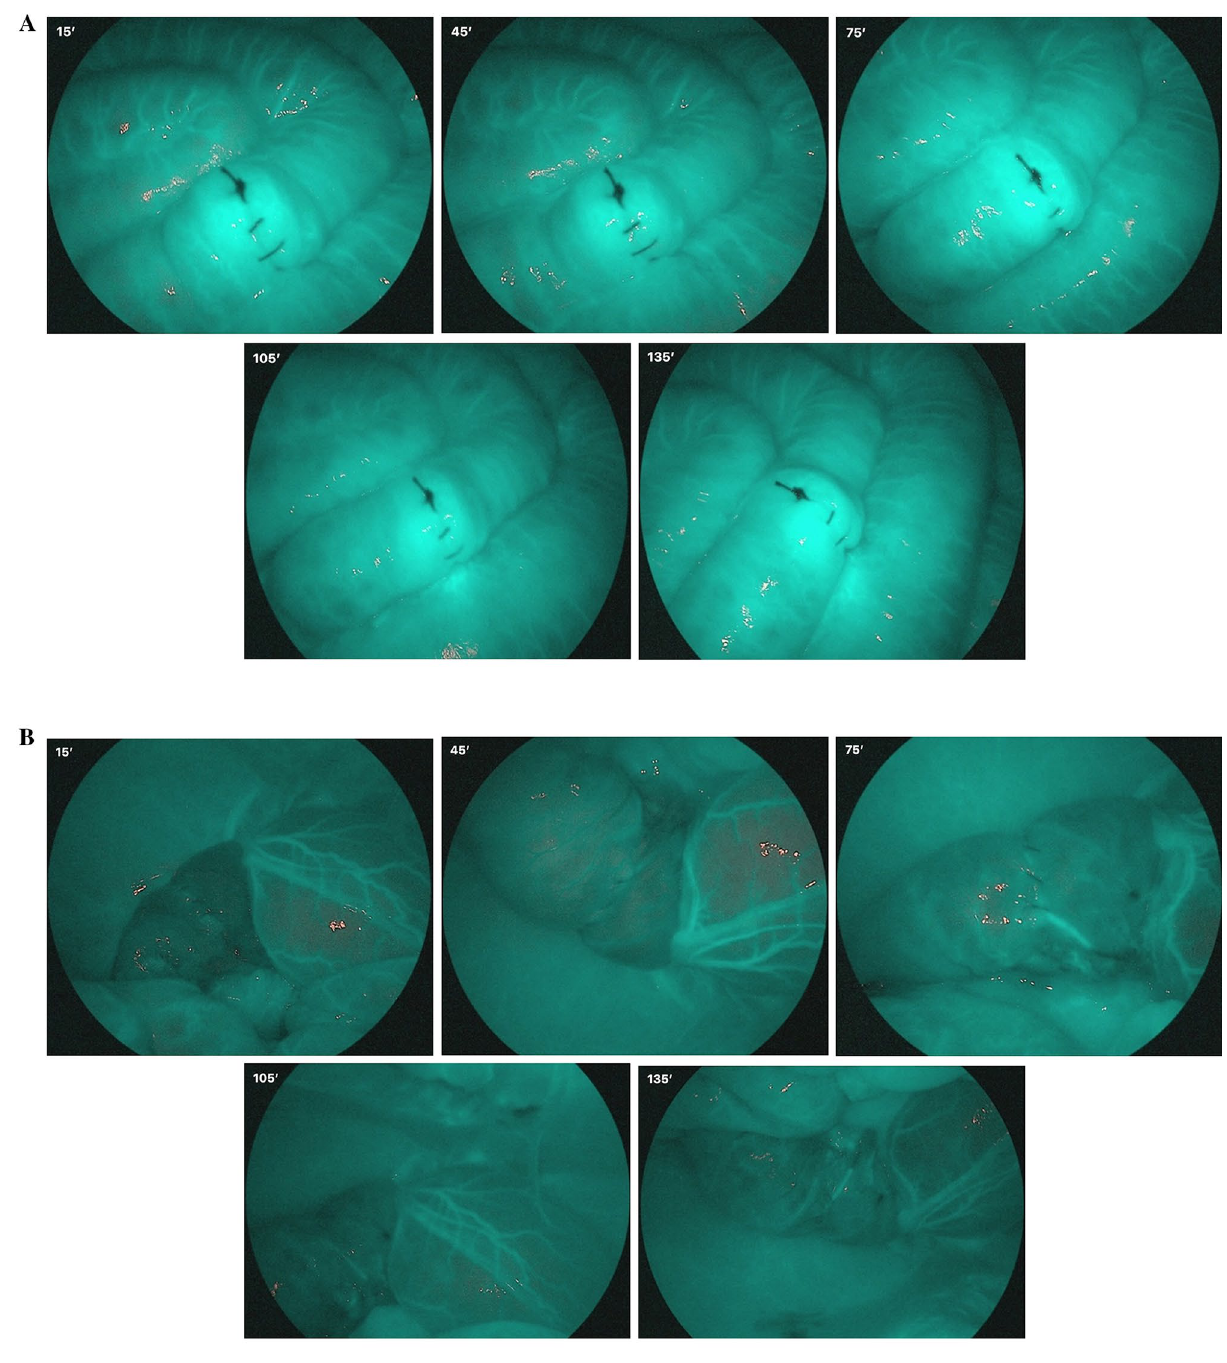
Figure 2. ( A ) Evolution in images of the right colon after sectioning of the inferior mesenteric artery. Images are taken at 15, 45, 75, 105 and 135 min after the arterial section. Vascularization remains uniform over time. ( B ) Evolution in images of the left colon after sectioning of the inferior mesenteric artery. Images are taken at 15, 45, 75, 105 and 135 min after the arterial section. Ischemia remains uniform over